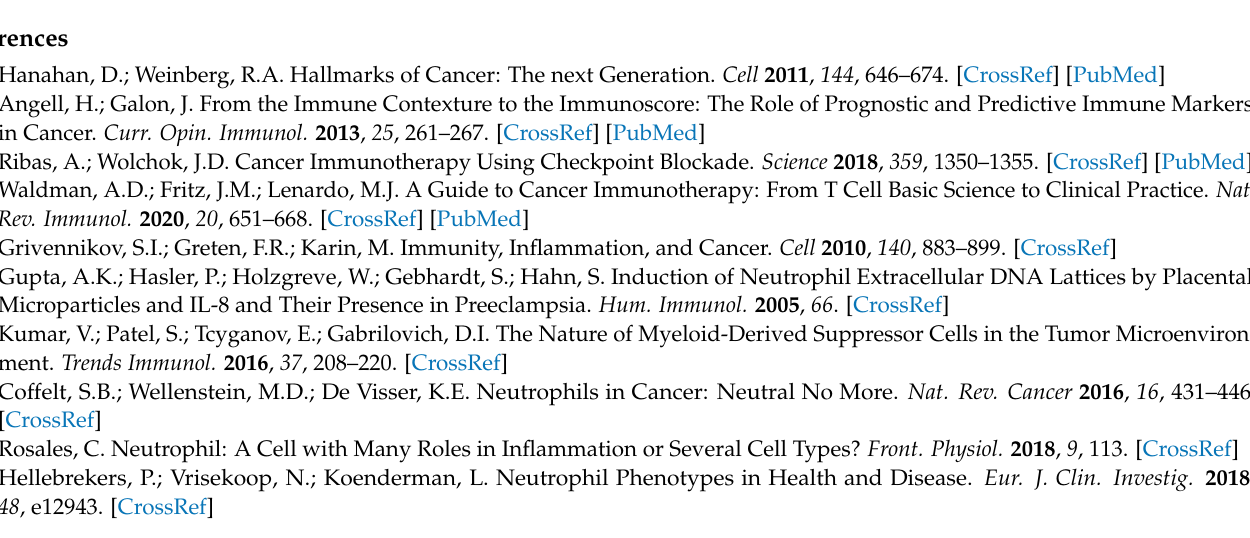
profile after 24 h of culture with melanoma-conditioned medium (MCM). Figure S4: Evaluation of the circulating neutrophils (Ly6G+) and monocytes (F4/80) on the 21st day after melanoma cells injection. Figure S5: Uncropped gel. Reference [80] is part of the Supplementary Materials